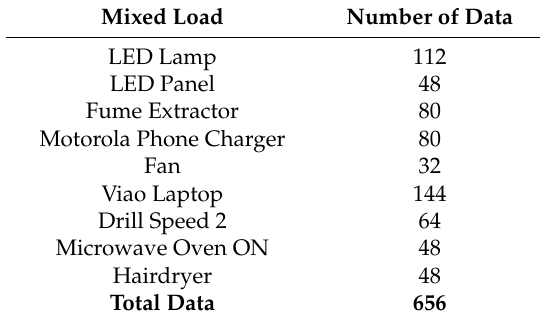
Table 1. Number of mixed load data containing target